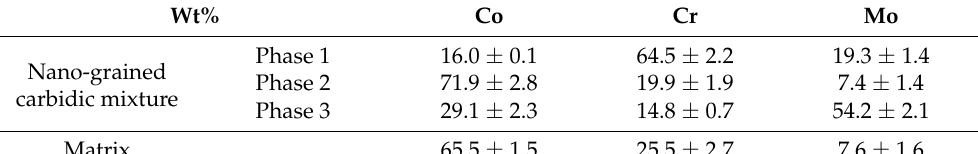
Table 4. Chemical composition of different phases of the cast Co-Cr-Mo alloy determined by TEM-EDS.